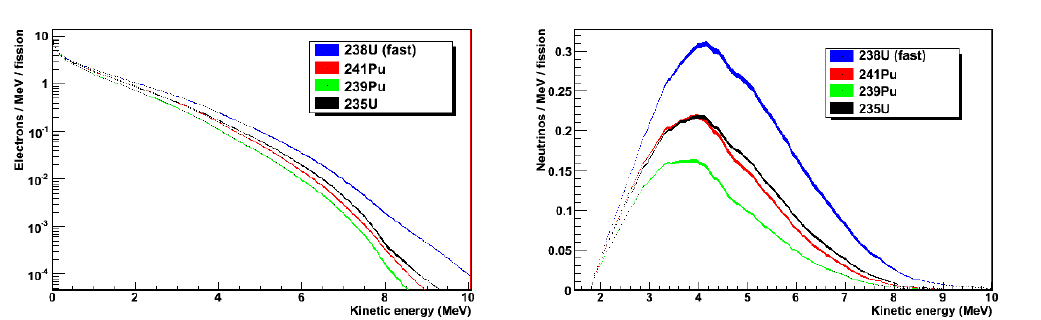
Figure 3. Electron (left) and anti-neutrino (right) energy spectra calculated for di ff erent fissioning systems using the cumulative fission yields from JEFF3.1.1 at 25.3 meV for 235 U, 239 Pu, 241 Pu and at 400 keV for 238 U. The anti-neutrino energy spectra are convoluted by the inverse beta-decay cross section from [27]. Propagated nuclear data base uncertainties are contained within the width of the